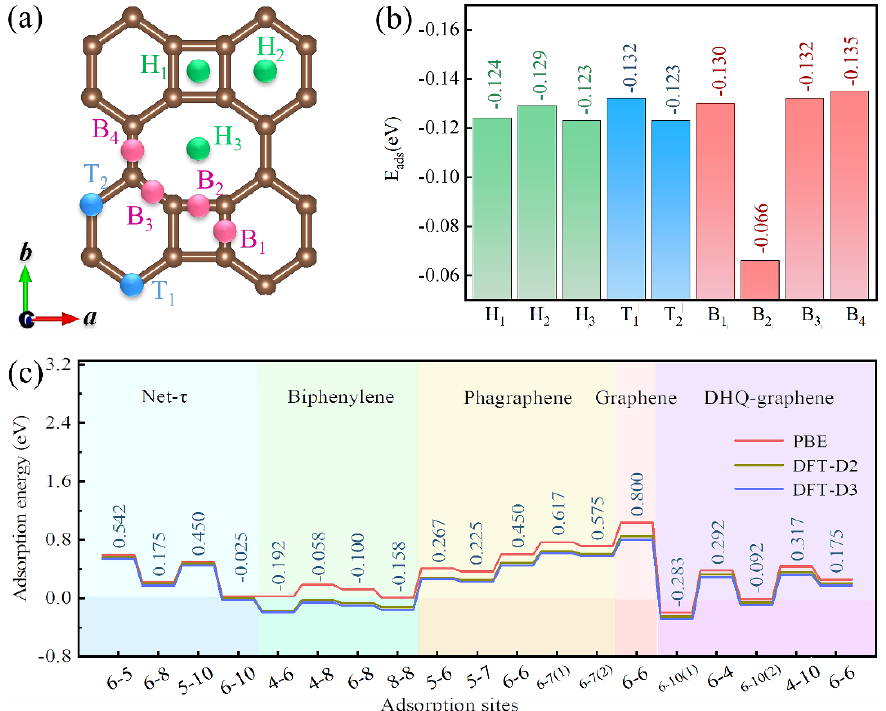
Figure 3. Adsorption properties of biphenylene. i − j, the bridge sites where i − and j − membered carbon rings intersect. ( a ) Adsorption sites of O atoms on the surface of biphenylene. ( b ) Adsorption energies of a single O atom adsorbed at different sites. ( c ) Adsorption energies of different graphene-based materials.